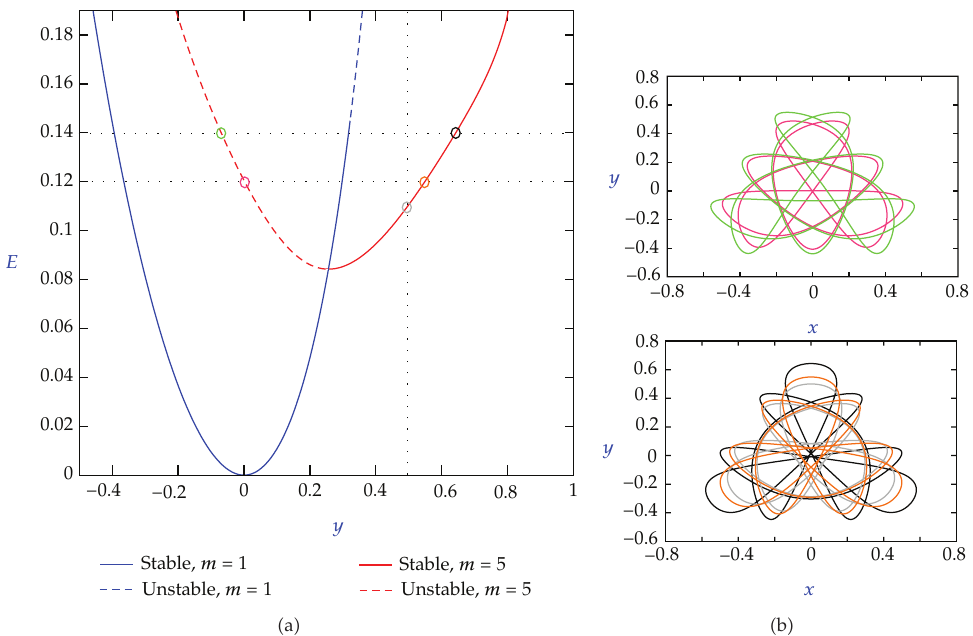
Figure 5: (cid:3) a (cid:4) continuation of two families of periodic orbits of the classical H´enon-Heiles Hamiltonian with x 0 (cid:8) Y 0 (cid:8) 0. Orbits with some selected values of the energy and coordinate y are pointed out. (cid:3) b (cid:4) corrected arbitrary precision periodic orbits corresponding to surrounded points following the color code; top, unstable orbits, and bottom, the stable